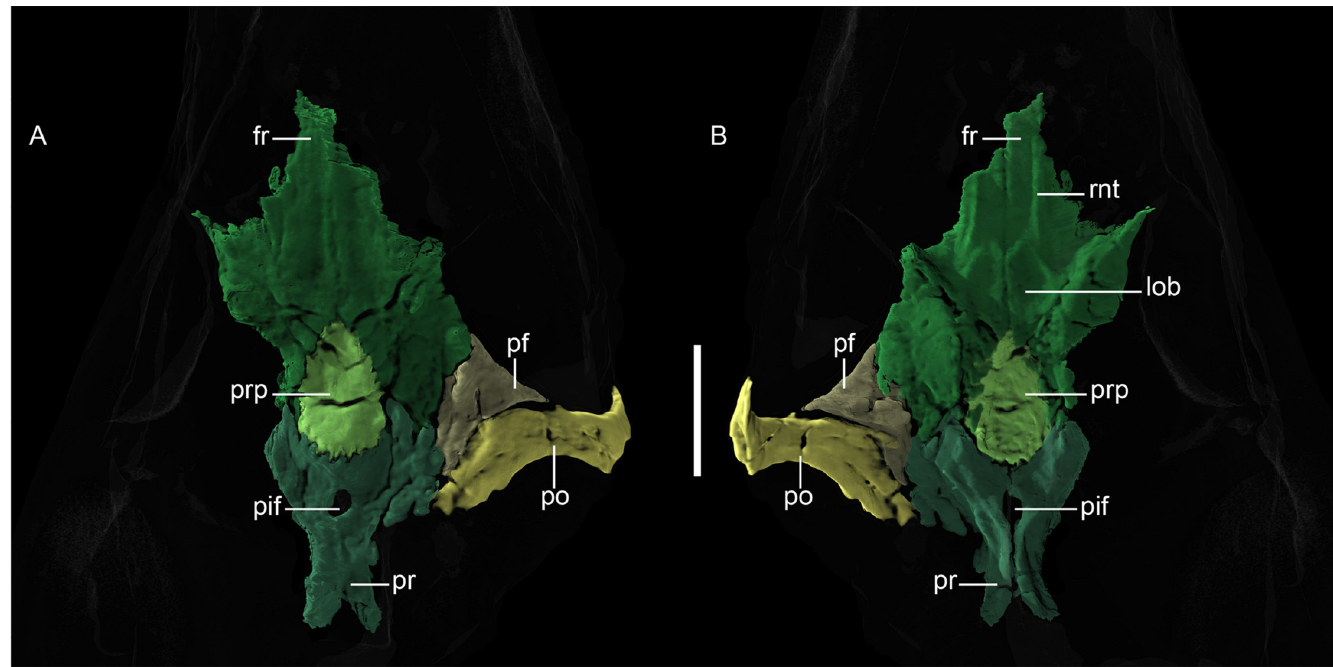
Fig 8. Neutron CT reconstruction of MB.R.999: skull roof from (A) dorsal and (B) ventral. Abbreviations: fr, frontal; lob, (position of) left olfactory bulb; pf; postfrontal; pif, parietal foramen; po, postorbital; pr, parietal; prp, preparietal; rnt: ridge for cartilaginous nasal turbinals. Scale bars = 2